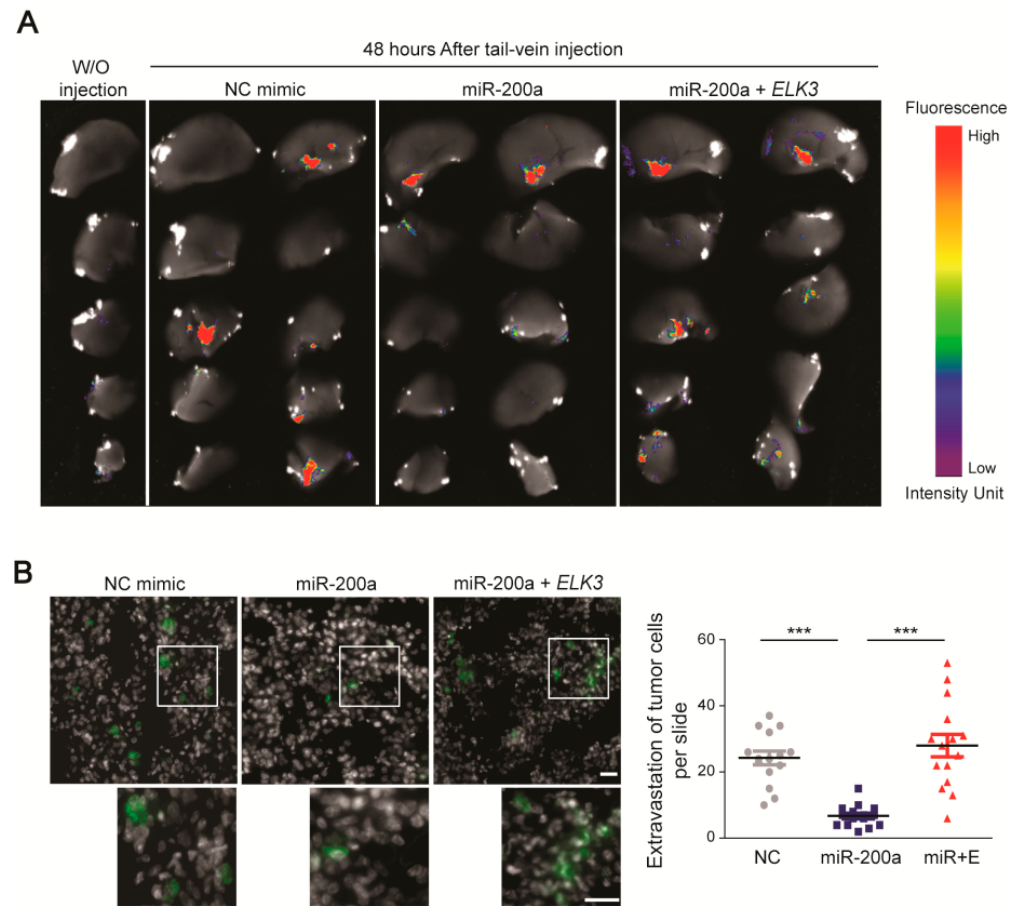
Figure 6. Functional link between miR-200a and ELK3 regulates the lung extravasation of MDA-MB 231 cells in vivo . ( A ) Fluorescence optical images of the lung 48 h after tail vein injection of mice with control MDA-MB 231 GFP-luciferase cells or those expressing miR-200a alone or miR-200a plus pcDNA3.1-Flag- ELK3 . “W/O injection” indicates negative control mice that did not receive a tail vein injection. ( B ) Immunofluorescence images of GFP, indicating extravasated tumor cells, in the lungs of mice injected via the tail vein as described for (a). The gray area indicates the nucleus. Scale bars, 20 μ m. Extravasation of tumor cells was determined by counting the number of GFP-positive cells. Error bars represent the S.E.M.; *** p < 0.001 (Student’s t -test).